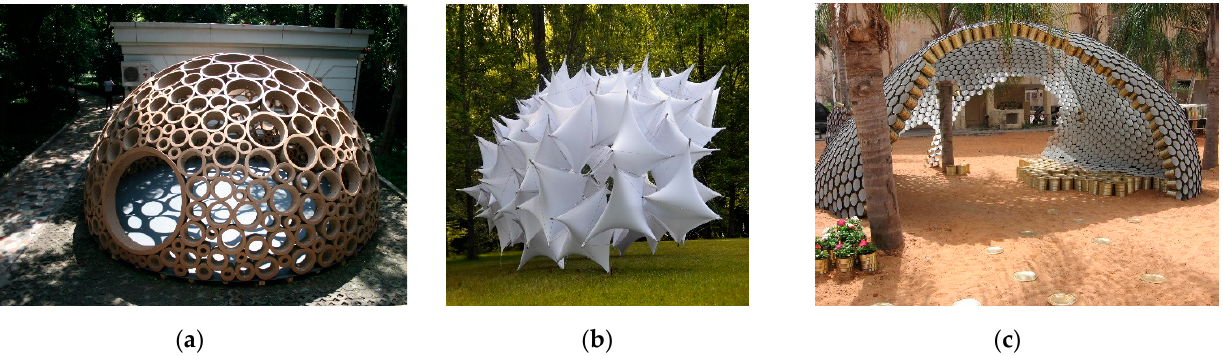
Figure 3. Temporary pavilions: ( a ) the Packed Pavilion, 2010, reproduced with permission from Dominik Zausinger; ( b ) the Underwood Pavilion, 2014, reproduced with permission from Gernot Riether; ( c ) the Can Pavilion, 2008, reproduced with permission from Lihi Ein-Gedi Davidovich.